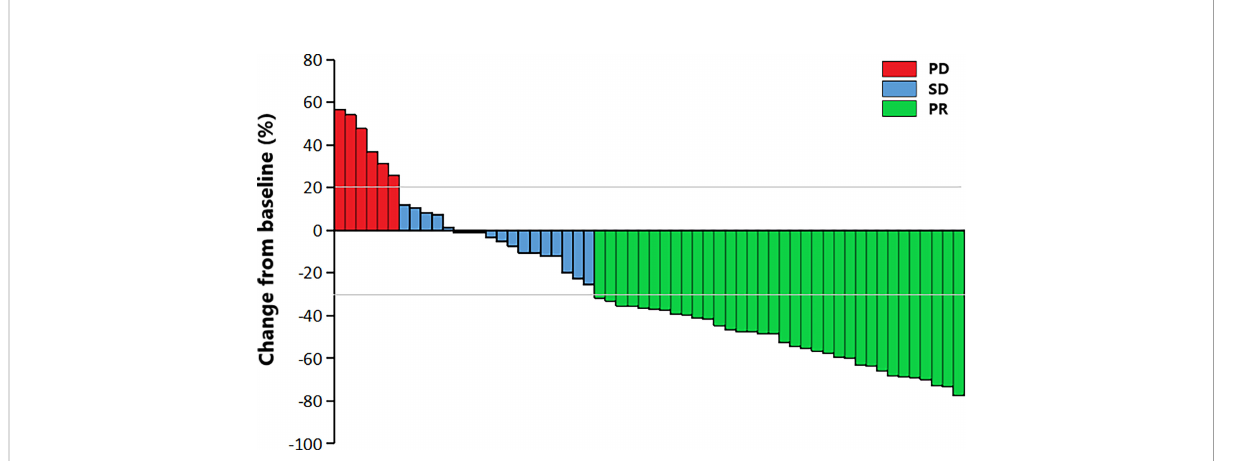
FIGURE 2 The waterfall plot of tumor best response compared with baseline measurable lesions. PR, partial response; SD, stable disease; PD, progressive